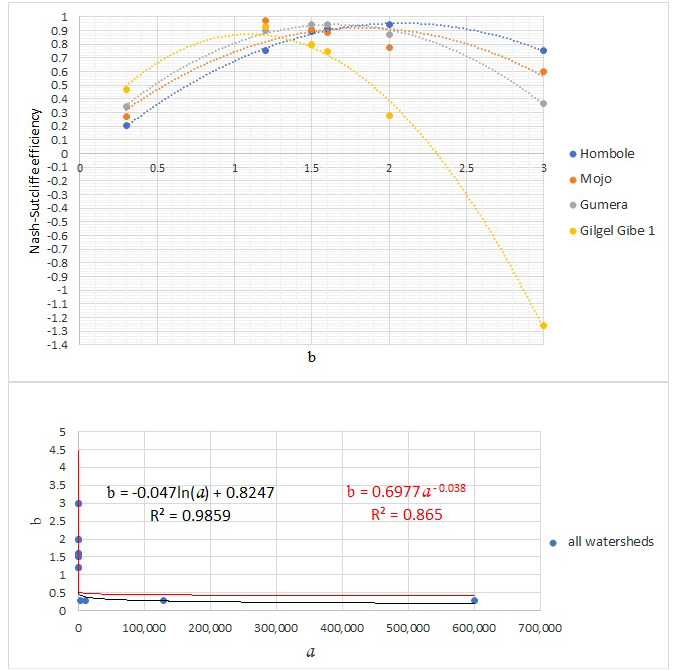
Figure 12. The relationship between exponent b versus the Nash–Sutcliffe efficiency and coefficient a versus exponent b when the topographic factor is calculated by using the equation that was proposed in